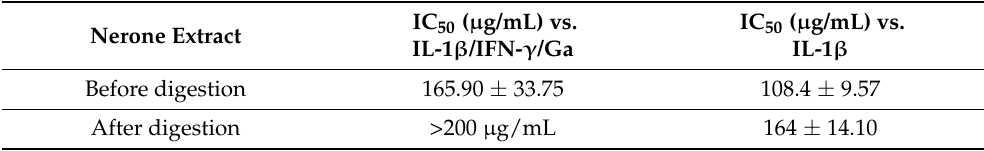
Figure 7. Effect of black rice extract from Nerone variety on NF- κ B-driven transcription after in vitro simulated digestion. Caco-2 cells were stimulated by IL-1 β (10 ng/mL) for 6 h. Unstimulated condition was also reported (white bar, Control − ) ( A ). The NF- κ B-driven transcription was measured by luciferase assay and expressed as mean emission ± SEM vs. stimulus (black bar, Control +), to which was arbitrarily attributed the value of 100% ( B ). * p < 0.05, *** p < 0.001 vs. stimulus. Table 4. IC 50 s of extracts from Nerone on the NF- κ B-driven transcription induced by IL-1 β /IFN- γ /Ga pro-inflammatory mix or IL-1 β